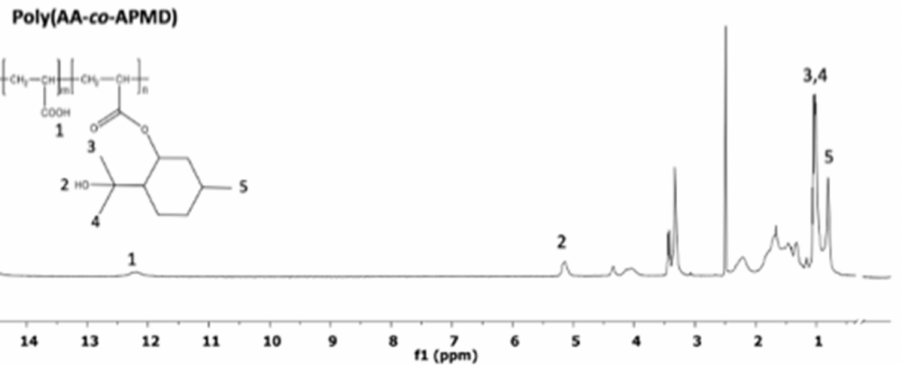
Figure 1. 1 H-NMR spectrum of poly(AA– co –acryloyl–p-menthane-3,8-diol (APMD)), showing reso- nances at (1) 12.25 ppm, (2) 5.2 ppm, (3) 1.2 ppm, (4) 1.1 ppm, and (5) 0.9